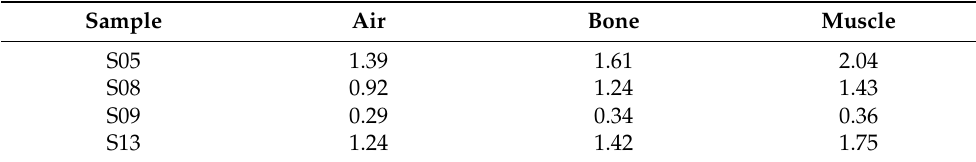
Table 3. Annual dose (in mSv/y) due to 238 U, 232 Th and 40 K, obtained using the HPC program.